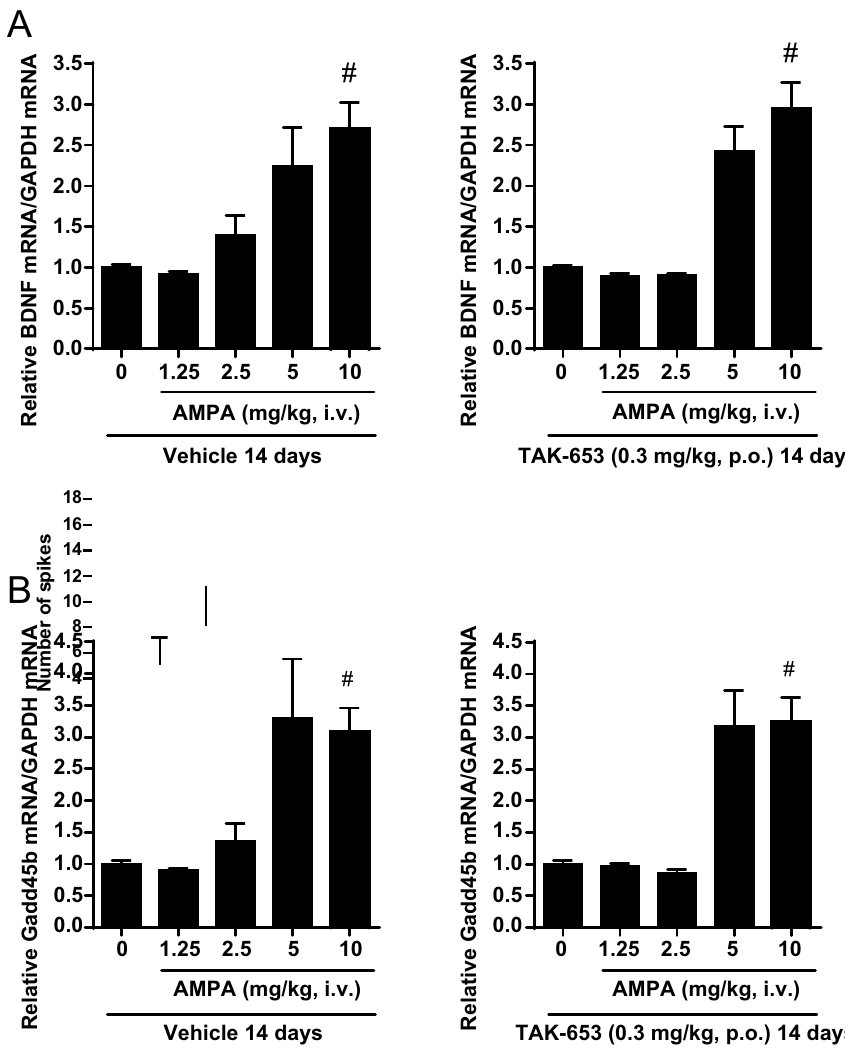
Figure 5. Effects of repeated treatment of TAK-653 on AMPA-induced BDNF ( A ) or Gadd45b ( B ) mRNA expression in mouse hippocampus. Vehicle or TAK-653 (0.3 mg/kg, p.o.) for 14 days were administered to mice. On the day 14, vehicle or AMPA (1.25, 2.5, 5 or 10 mg/kg, i.v.) was administered 1 h after vehicle (left) or TAK-653 (right). Tissues were isolated 3 h after AMPA administration. Data were presented as the mean ± SEM (n = 23–24). # P ≤ 0.05 (versus vehicle-treated group; two-tailed Shirley–Williams